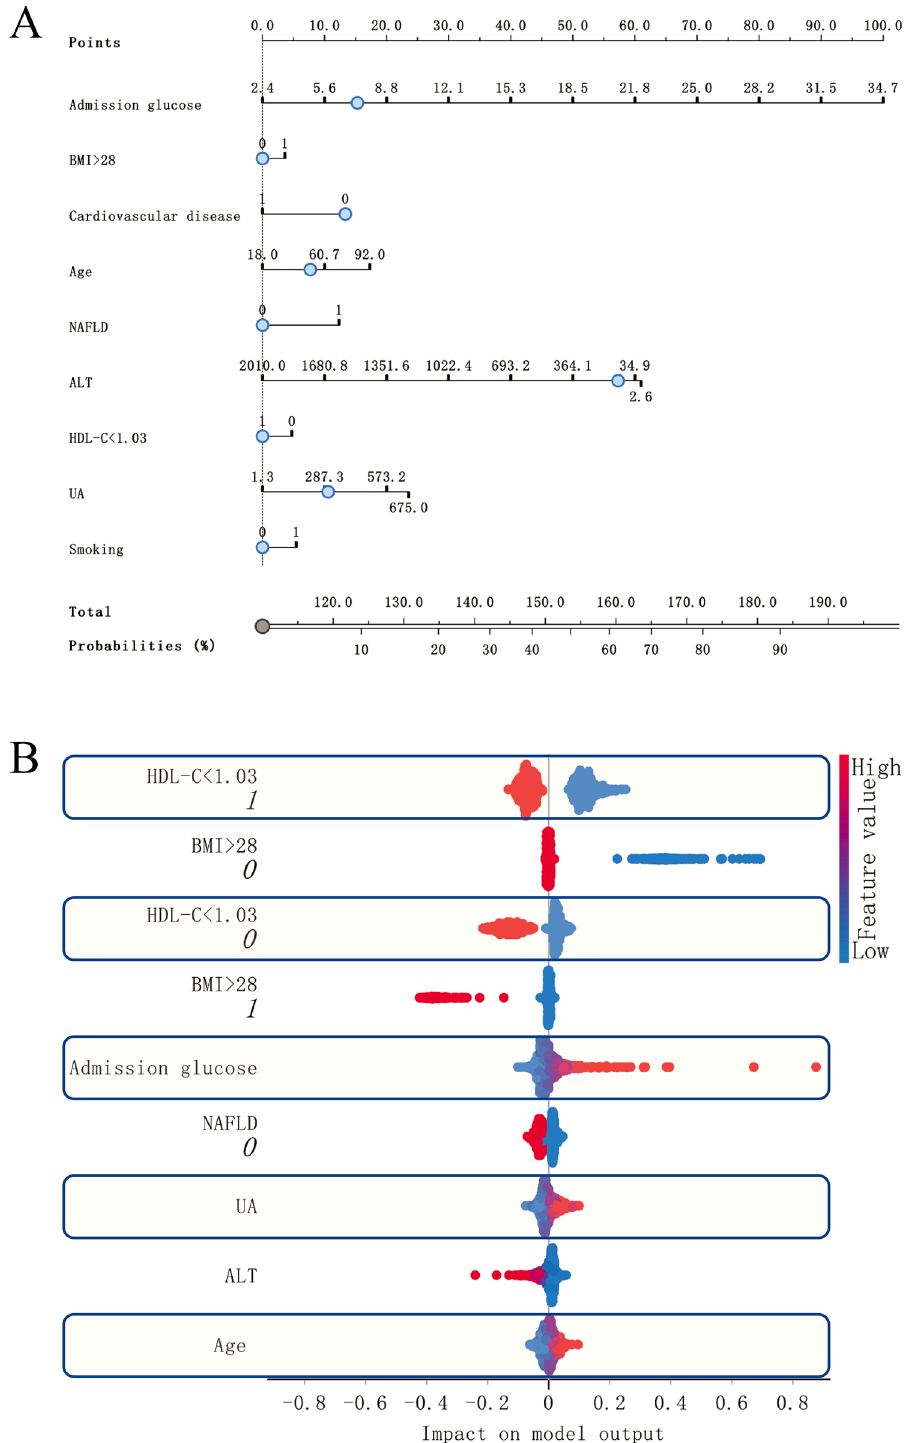
Figure 3. Model interpretation. We have used two methods of model interpretation. ( A ) Nomogram. The trend and magnitude of the effect of the nine core factors on the prediction of positive events can be observed in the figure. Admission glucose, BMI > 28, Age, NAFLD, UA and Smoking are the risk factors for PPDM-A. In contrast, Cardiovascular disease, ALT, HDL-C < 1.03 are negative predicted factors. ( B ) Sharpley value was used to explain the effect of the model on prediction. HDL-C < 1.03, BMI > 28 and Admission Glucose were the main factors affecting prediction. BMI > 28, Cardiovascular disease, HDL-C < 1.03 and Smoking are logistic variables, with 0 being FALSE and 1 being